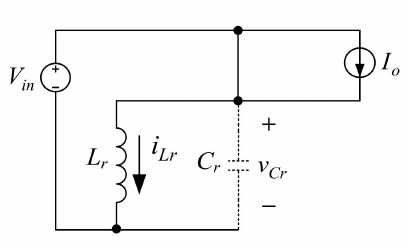
Figure 6. Equivalent circuit in state